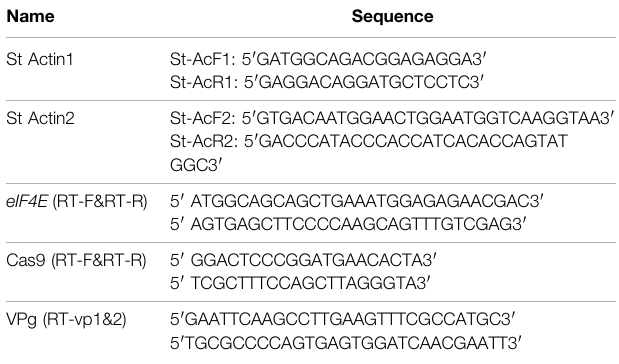
TABLE 3 | Primers sequences used in